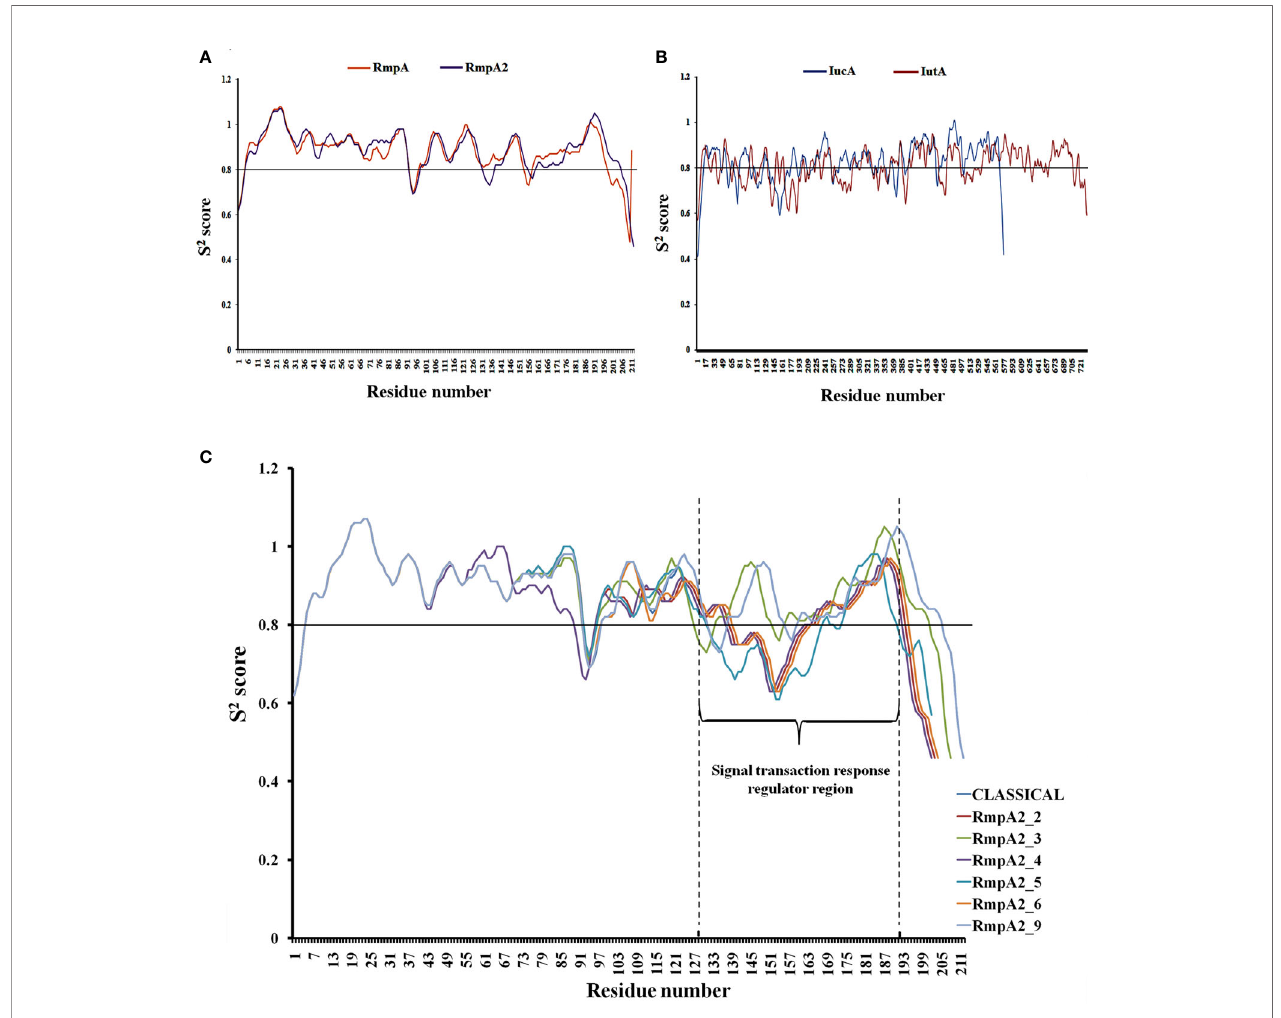
FIGURE 5 | Backbone stability analysis: The relatively rigid (S2 score>0.8) and fl exible (S2 score<0.8) regions of (A) RmpA and RmpA2 (B) IutA and IucA. (C) The variants of RmpA2 with shifts in the backbone as a resultant of frameshift